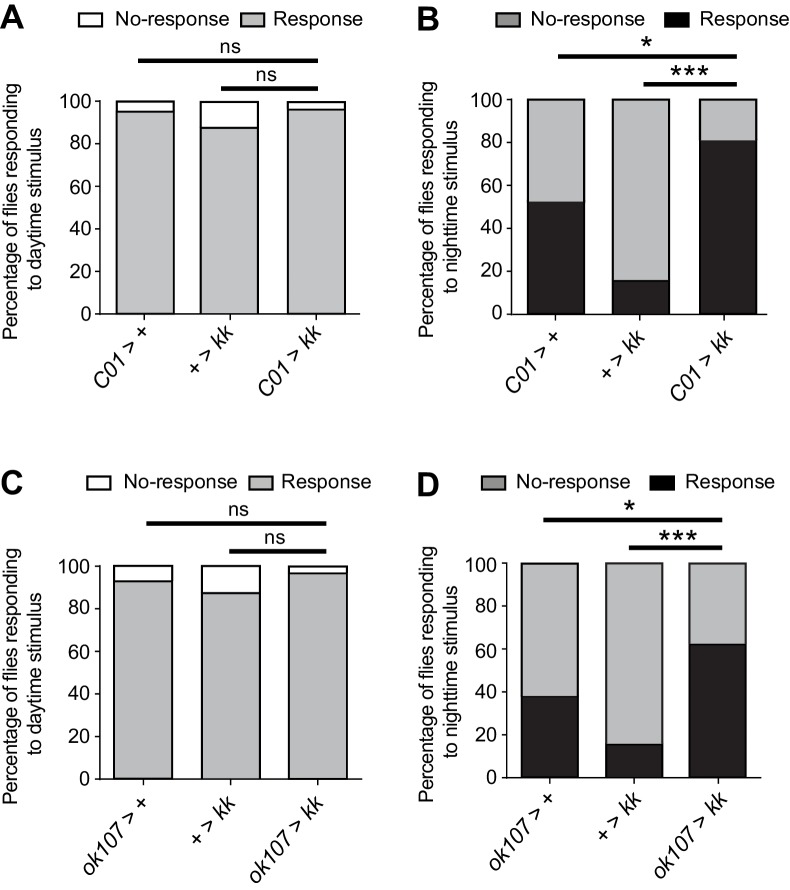
NCA acts in the mushroom bodies to regulate nocturnal arousal.(A–B) Percentage of adult male flies expressing Nca RNAi (kk) in C01-neurons (C01 > kk) and control flies responding or not responding to vibration stimulus at either ZT4 (day; A) or ZT16 (night; B). ZT4: C01 > +, n = 22, + > kk, n = 61, C01 > kk, n = 27. ZT16: C01 > +, n = 19, + > kk, n = 54, C01 > kk, n = 21. (C–D) Percentage of adult male flies expressing Nca RNAi (kk) in MB-KCs (ok107 > kk) and control flies responding or not responding to vibration stimulus at either ZT4 (day; C) or ZT16 (night; D). ZT4: ok107 > +, n = 26, + > kk, n = 47, ok107 > kk, n = 28. ZT16: ok107 > +, n = 26, + > kk, n = 44, ok107 > kk, n = 27. ns – p>0.05, *p<0.05, ***p<0.001, Binomial test with Bonferonni correction for multiple comparisons.10.7554/eLife.38114.025Figure 6—source data 1.Proportion of flies responding to mechanical stimuli following Nca knockdown in C01- or ok107-neurons.